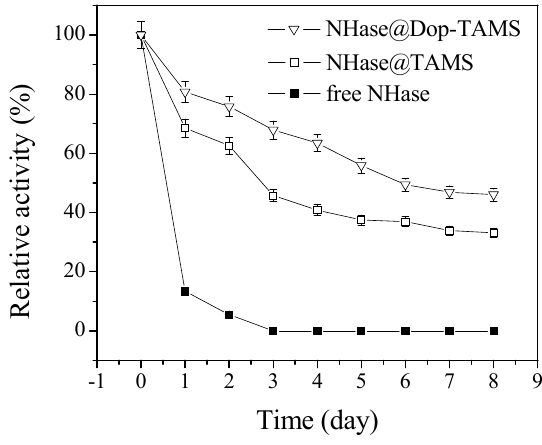
Figure7. The stability of free and immobilized NHasein shaking conditions. Figure 7. The stability of free and immobilized NHasein shaking